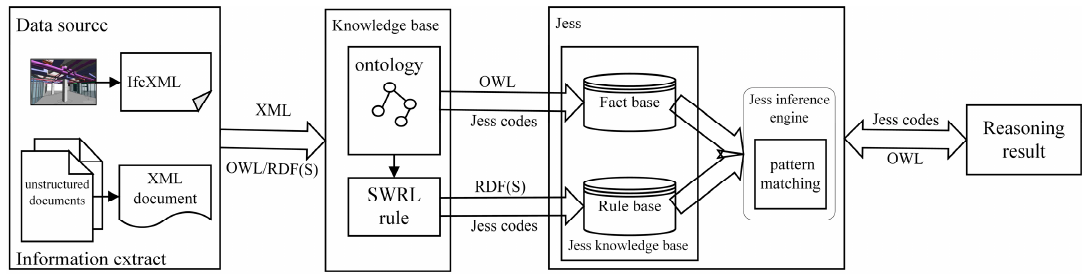
Figure 10. Flowchart of cost estimation reasoning.